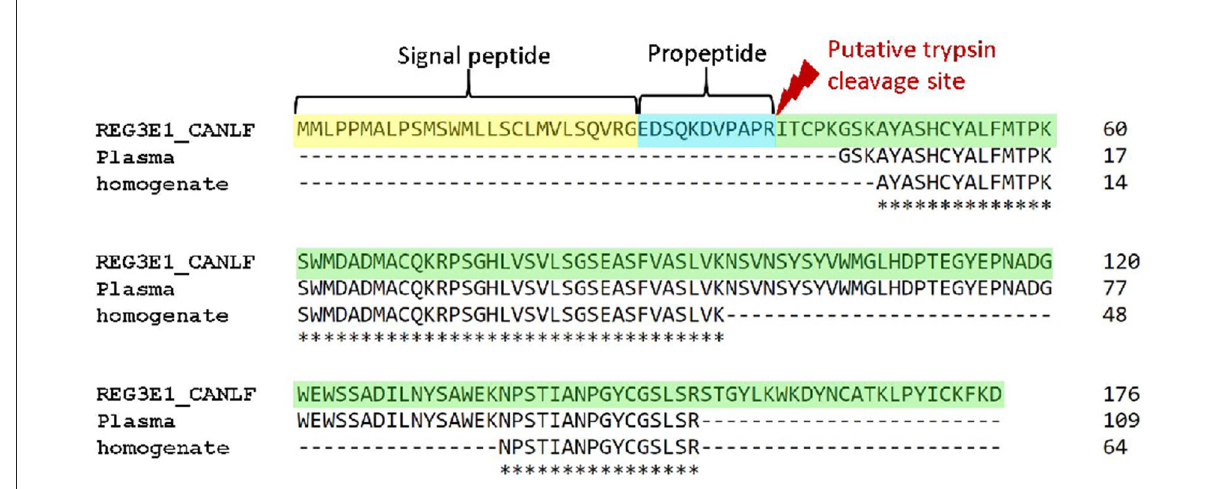
FIGURE6 Alignments of canine REG3E protein with protein sequences obtained from canine plasma and pancreas homogenates with mass spectrometry. N-terminal sequences corresponding to the human signal peptide and propeptide are highlighted in yellow and blue,